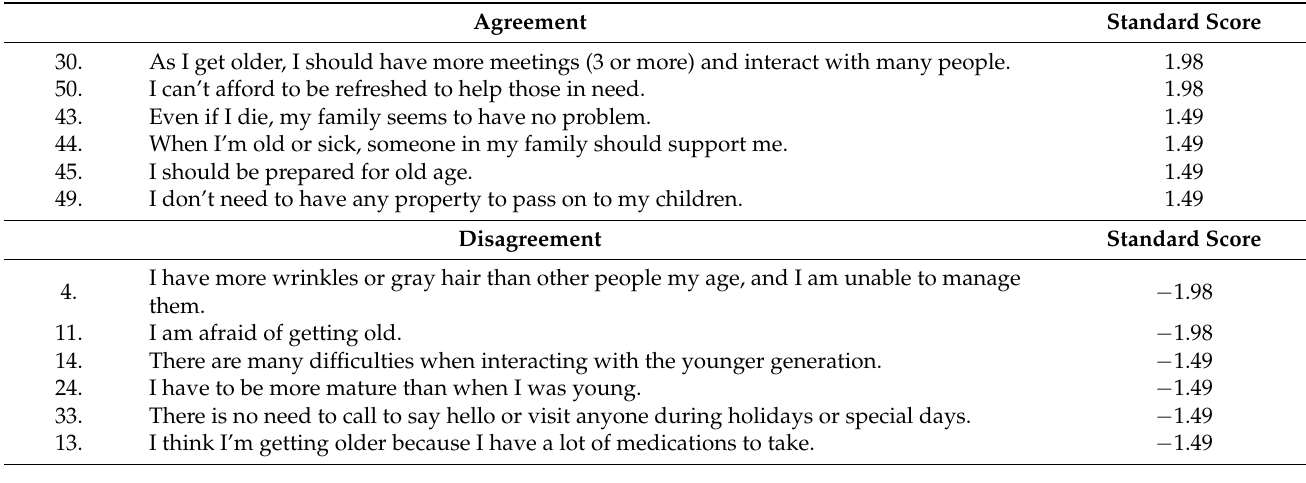
Table 8. The Q-statements with strong agreement or disagreement by Type